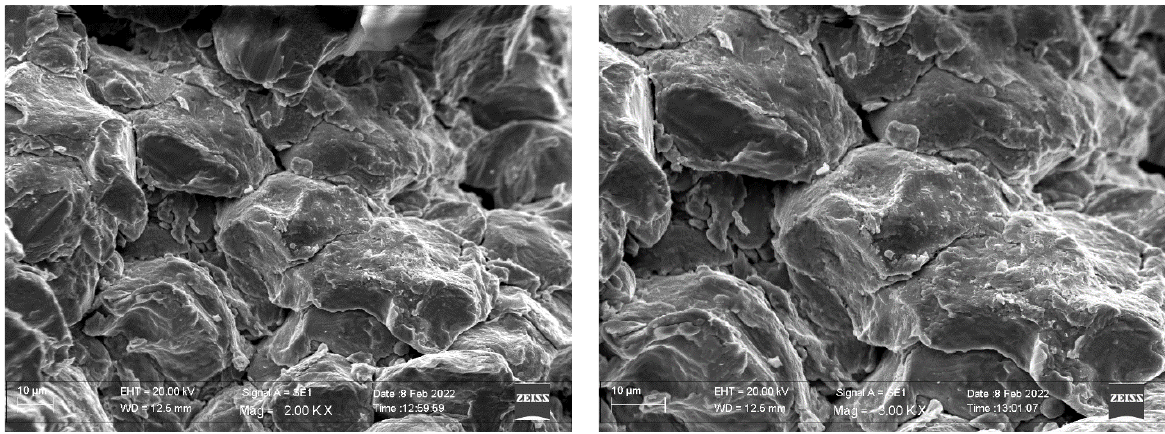
Figure 14. Local ductility features observed at the particle – particle interfaces after fracture.